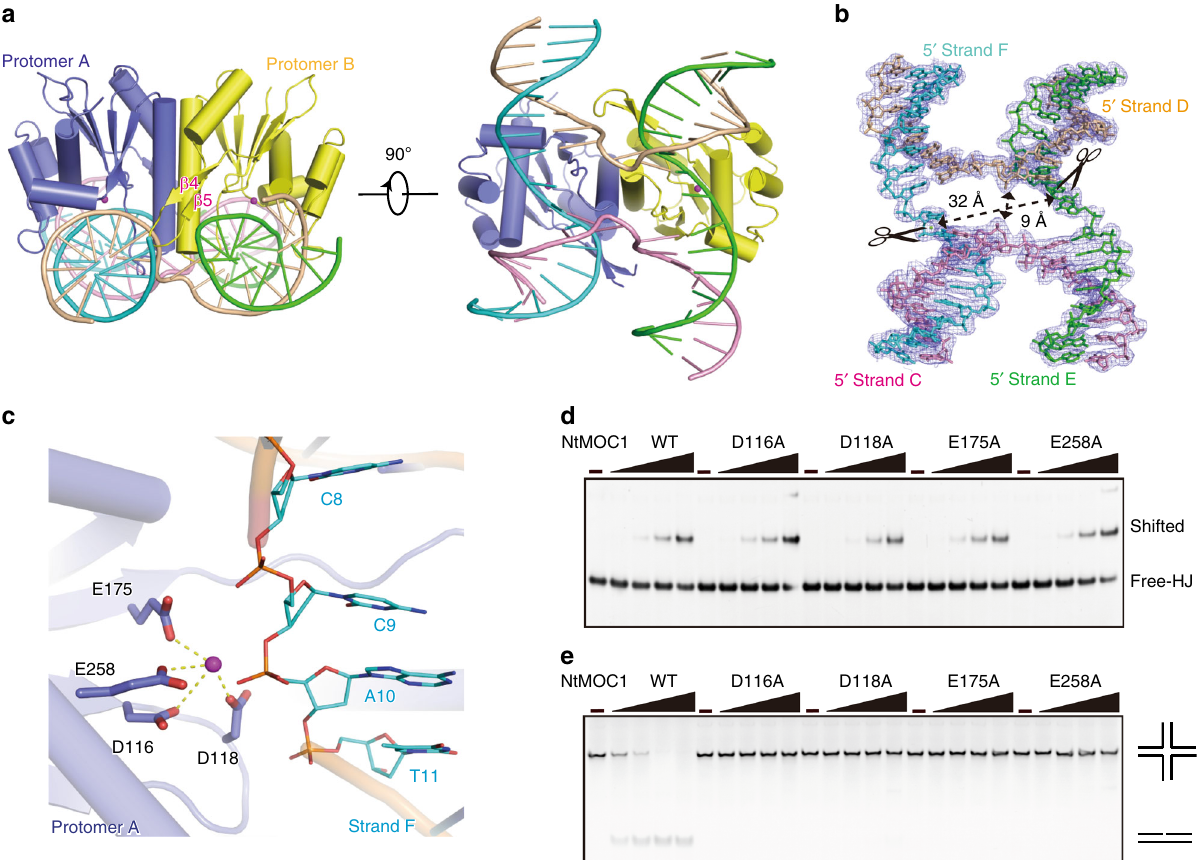
Fig. 3 Crystal structure of NtMOC1 in complex with a synthetic HJ. a Two perpendicular views of the complex structure. Subunits of the protein dimer are shown in slate and yellow. The four DNA strands C, D, E, and F are colored in pink, wheat, cyan, and green, respectively. The HJ is embedded into the cleft of the dimeric enzyme. b Structure of the HJ in the complex. The electron density map is contoured at 1.0 σ . Scissors indicate the scissile phosphates. Distances between the exchanging and non-exchanging strands are measured. c Active centers of NtMOC1. The magnesium ions are shown as purple spheres. Four acidic amino acids, coordinating with magnesium, constitute the catalytic tetrad. d Mutations at the catalytic tetrad of NtMOC1 have no effect on the HJ binding activity. e Mutations at the catalytic tetrad of NtMOC1 abolish the HJ cleavage activity. For the HJ binding and cleavage assay, X2 (CCGG) was used as HJ substrate. The fi nal concentration of HJ in each lane was 250 nM. Five gradients with increasing concentrations (0, 125, 250, 500, and 1000 nM) were applied for each protein sample. The reactions were resolved by native PAGE and visualized by GelRed staining. Source data are provided as a Source Data fi